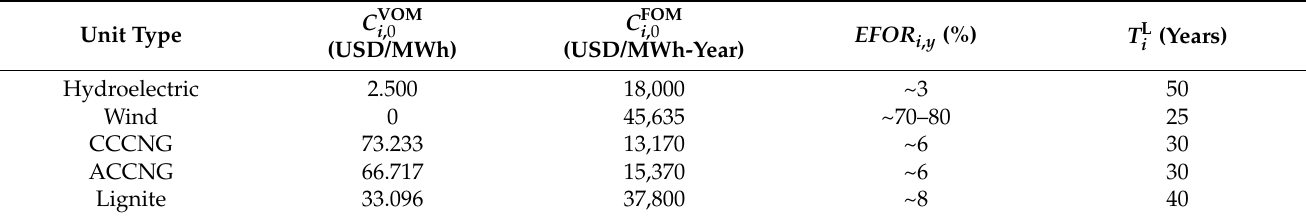
Table 5. The parameters of generation